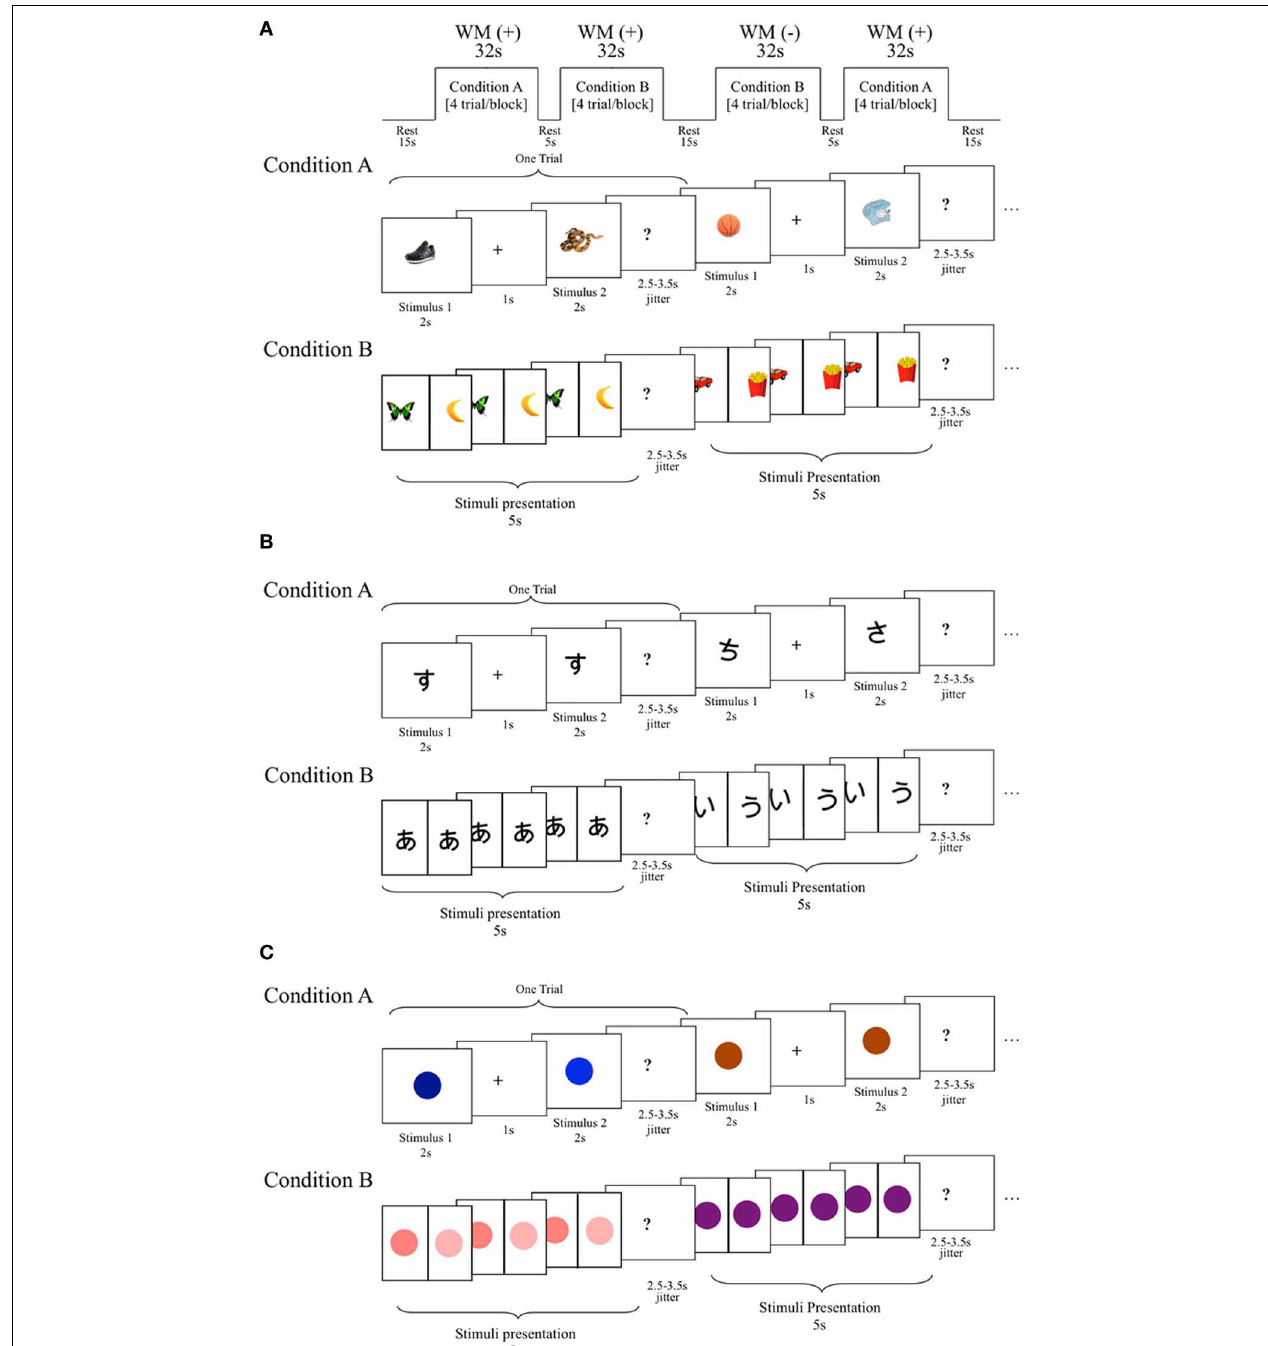
FIGURE 1 | Schematic diagram of the functional magnetic resonance imaging (fMRI) tasks. (A) Phonological processing fMRI task. In this block design fMRI task, participants were asked to determine whether the name of the pictured stimuli begin with matching sounds. Condition A: required working memory (WM + ), stimulus presented one after another for 2s each with 1s intervals (must be retained across a delay). Condition B: no working memory required (WM − ), stimuli presented side-by-side for 5s. Conditioned collapsed for the purposes of this study. (B) A visual-symbol matching block design fMRI task. Design was the same as phonological task except that Japanese hiragana symbols were presented instead of pictured objects, and